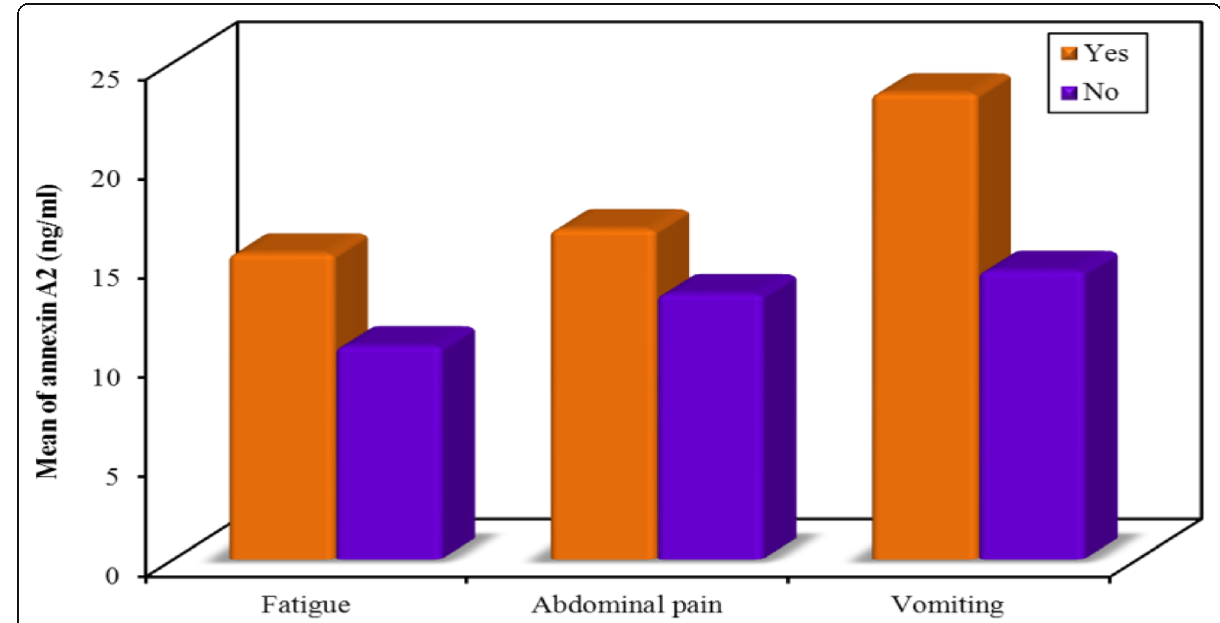
Fig. 1 Relation between ANXA2 and fatigue, and abdominal pain and vomiting in HCC group (group